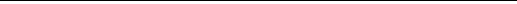
BOX 1 | Participation of muscle fibro-adipogenic progenitors in DMD pathology. DMD is a severe human myopathy without cure to date. It is caused by mutations in the DMD gene encoding DYSTROPHIN and characterized by muscular degeneration in which progressive loss of muscle mass and weakness are expected consequences (Hoffman et al., 1987; Wallace and McNally, 2009). Myonecrosis, sarcolemmal disorganization, inflammation, and the accumulation of fibro-fatty scar tissue are observed early in DMD and increase with age (Cáceres et al.,